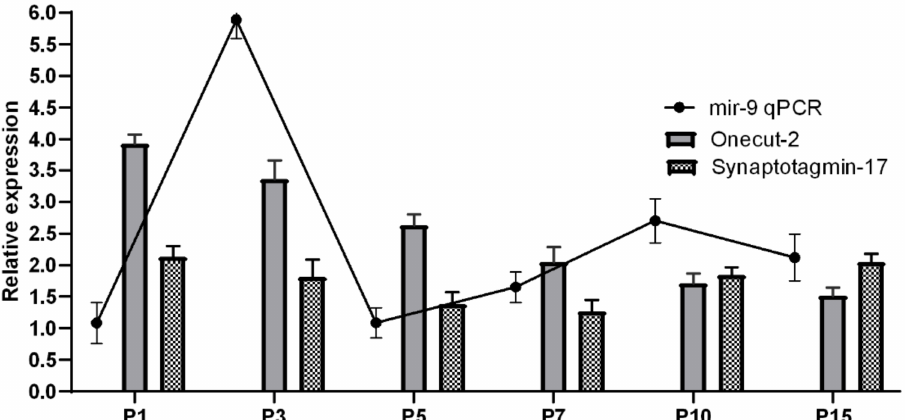
Figure 3. Relative expression levels of miR-9 target genes: OneCut2 (gray), synaptotagmin-17 (spot- ted) and mir-9 (black line) determined by RT-qPCR. Target genes expression levels were normalized against glyceraldehyde-3-phosphate dehydrogenase (GAPDH) as an internal control gene. The change in mir-9 expression was calculated with U6snRNA as a reference gene for normalization. Expression was compared with